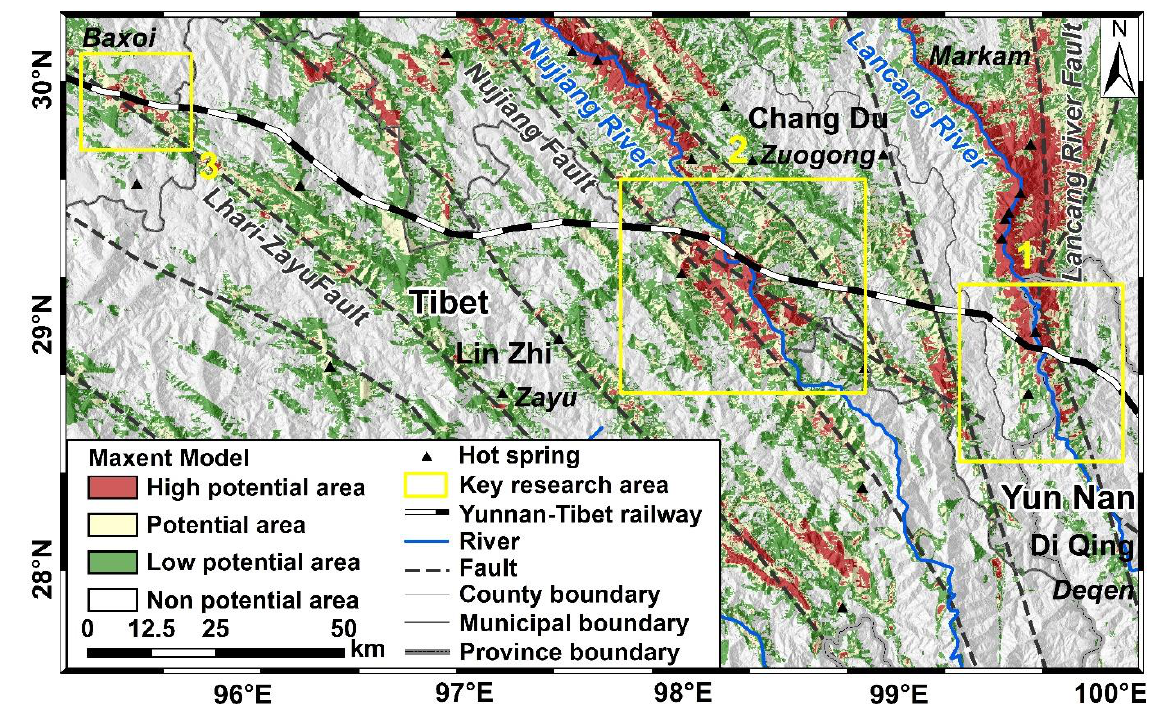
Figure 10. Key areas of geothermal disaster along the Yunnan – Tibet railway.